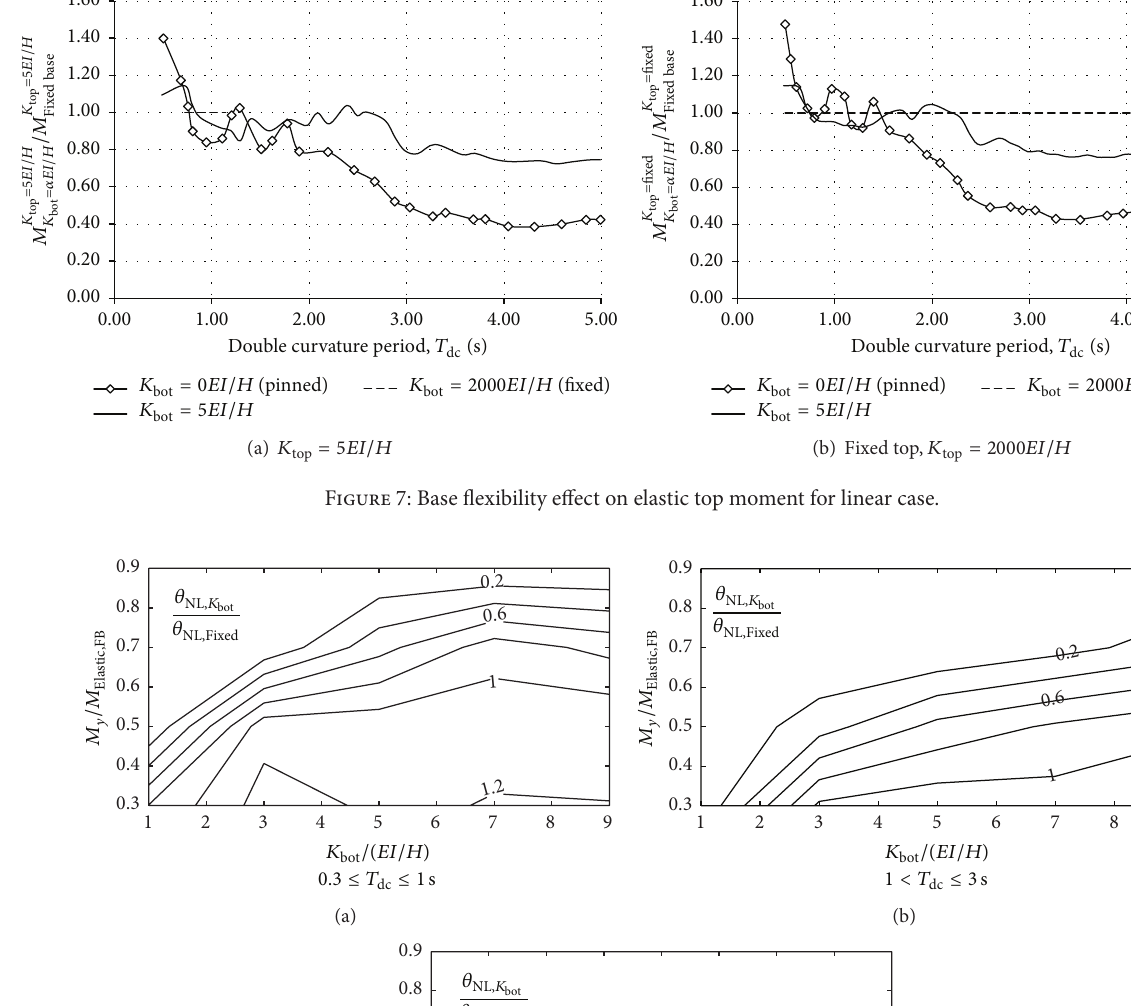
/(𝐸𝐼/𝐻) ) and yielding moment bot